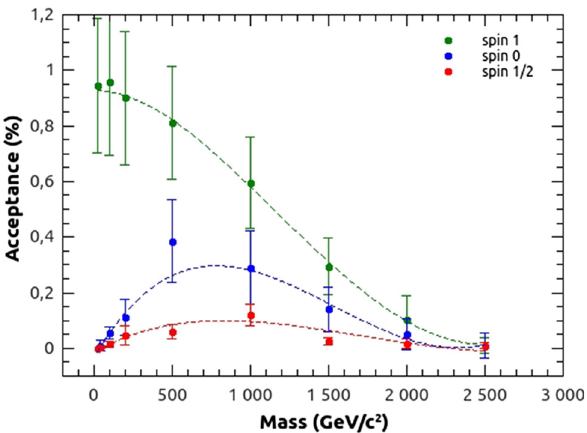
Fig. 12 Acceptance for spin-1, spin-0 and spin-1/2 HECOs with charge 125 e , produced via a DY process with virtual photon exchange only. The dashed lines represent 4th order polynomial fits to the data